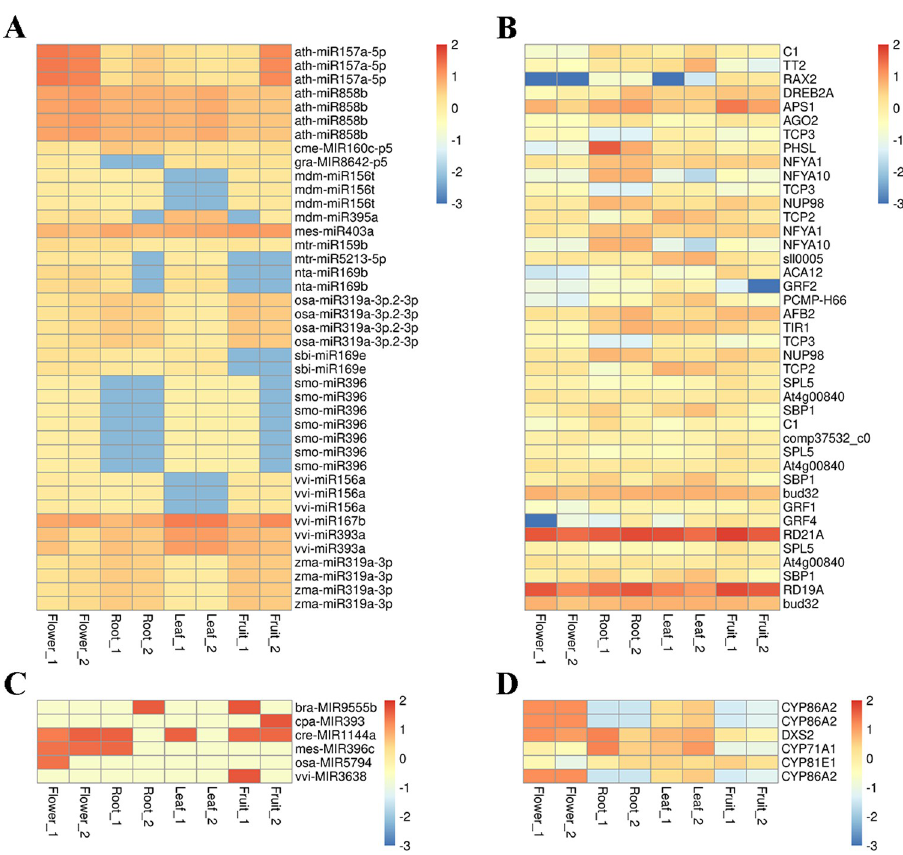
Fig 10. A combined views of the expressing level between miRNAs and their targets with differential expression in Paeonia . (A and B showed the one-to-one mapping correlation by DEMs in Paeonia , C and D showed the one-to-one mapping correlation by DEGs in monoterpenoids biosynthesis pathway of Paeonia ).